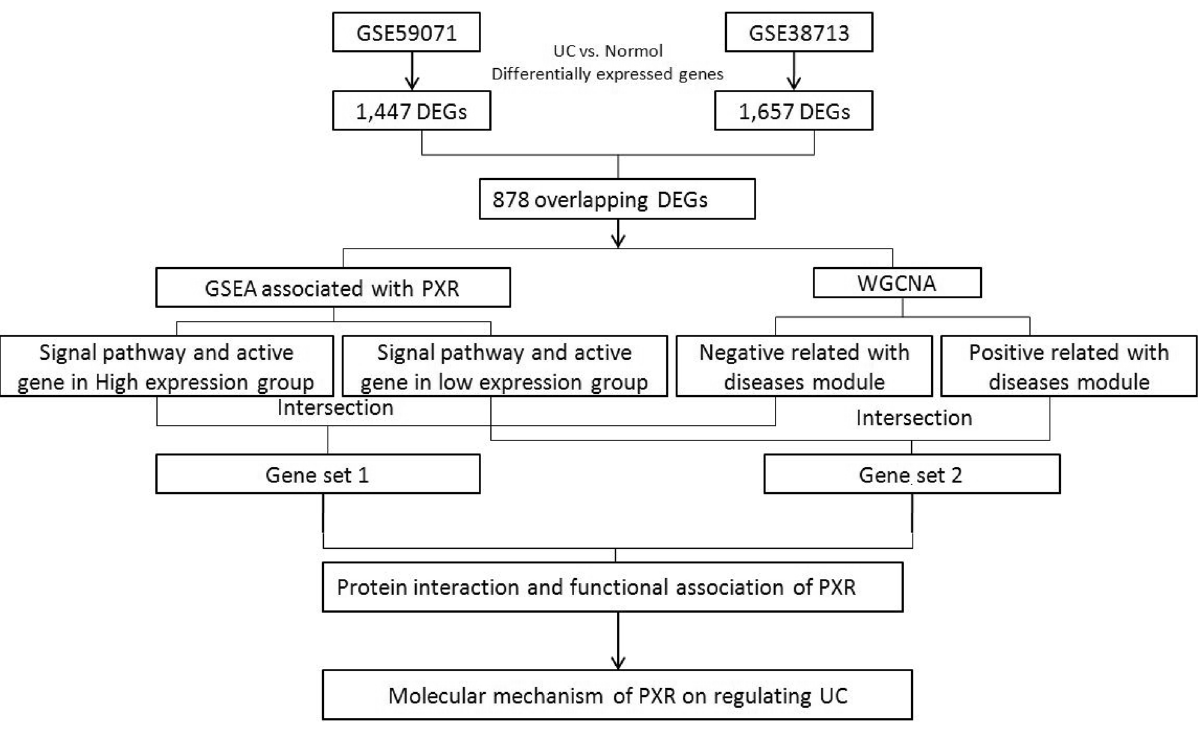
Figure 1. Flow diagram of